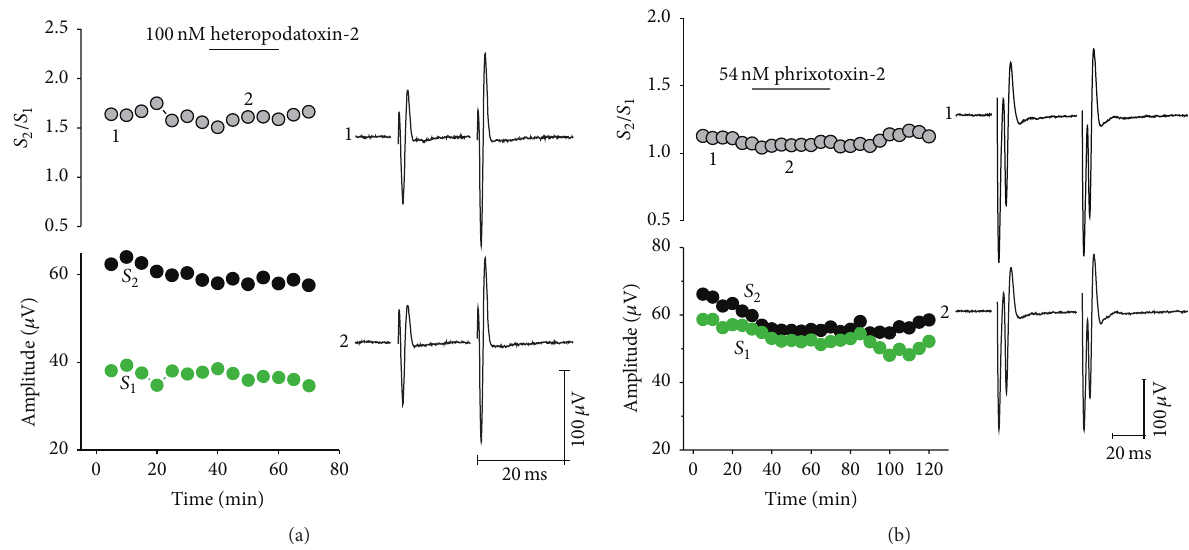
Figure 2: K V 4 family K + specific blockers do not modify PPF. Representative experiments are shown to exemplify that neither PPR (left upper panels) nor population-spike amplitude (left bottom panels) was modified by exposure to heteropodatoxin (a) or phrixotoxin (b). In this figure and Figures 3–6 horizontal bars indicate time of drug perfusion, the traces recorded before (1) and after (2) exposure to K V 4 toxins are shown on the right panels.